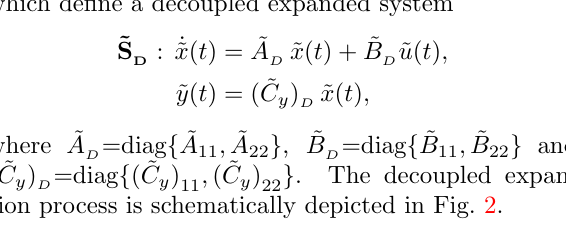
Figure 2: Decoupled expansion of an overlapping